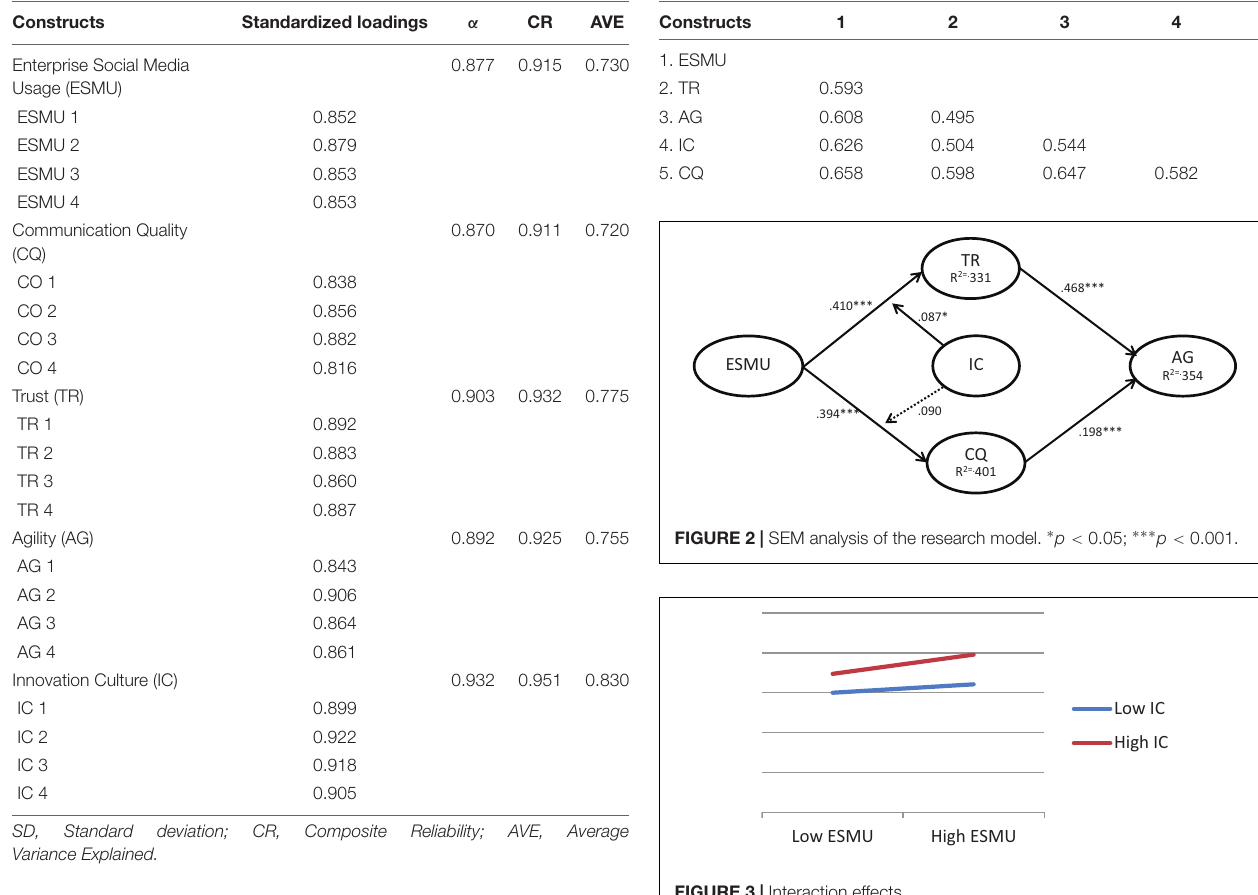
TABLE 4 | Heterotesait-monotrait (HTMT).